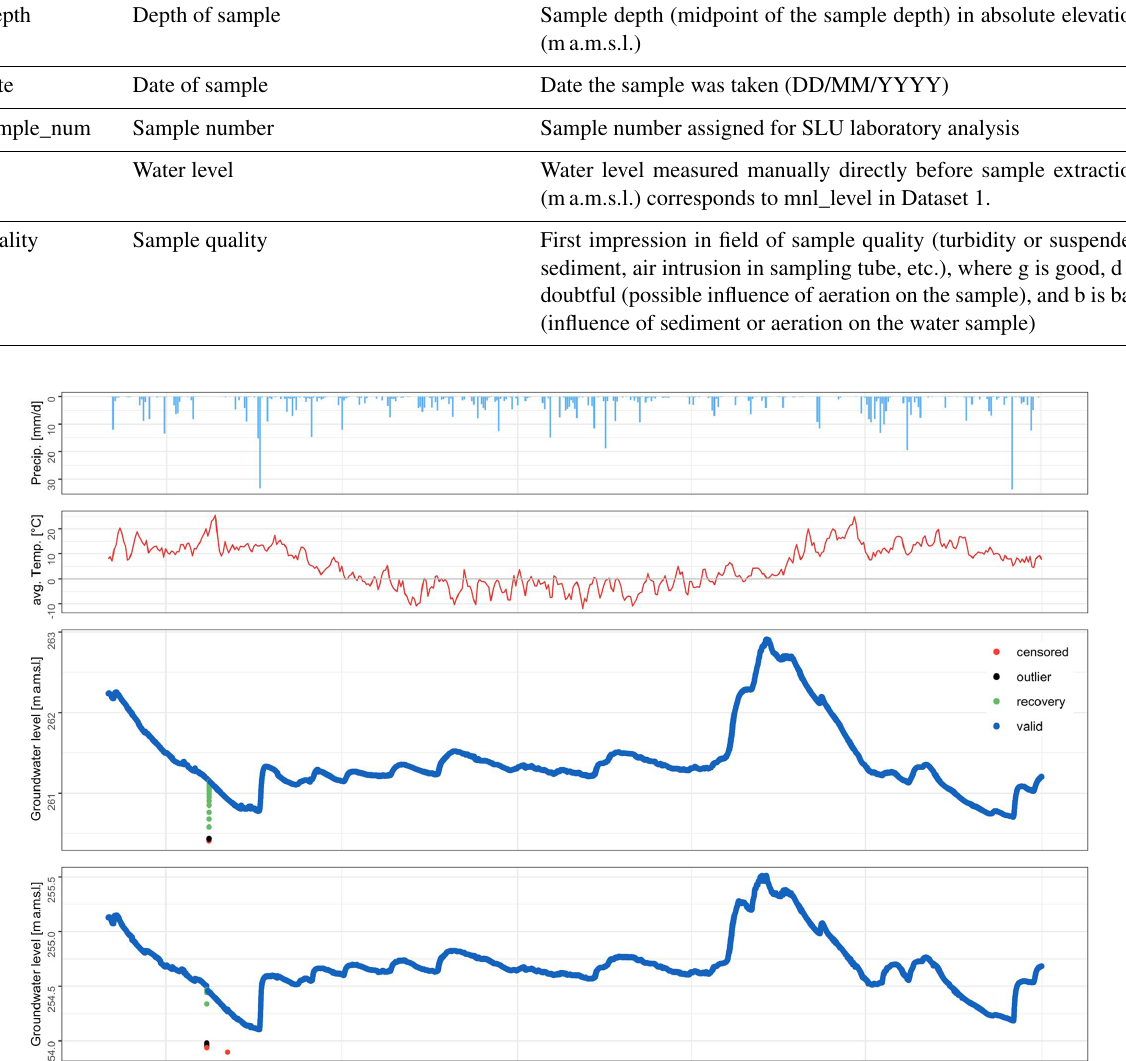
Figure 8. Precipitation (first plot; blue bars), temperature (daily average; second plot; red line), and classified groundwater levels for two wells (A12 in the third plot; B18 in the fourth plot) between June 2019 and September 2020. See Table C1 for further information on the classification of the data